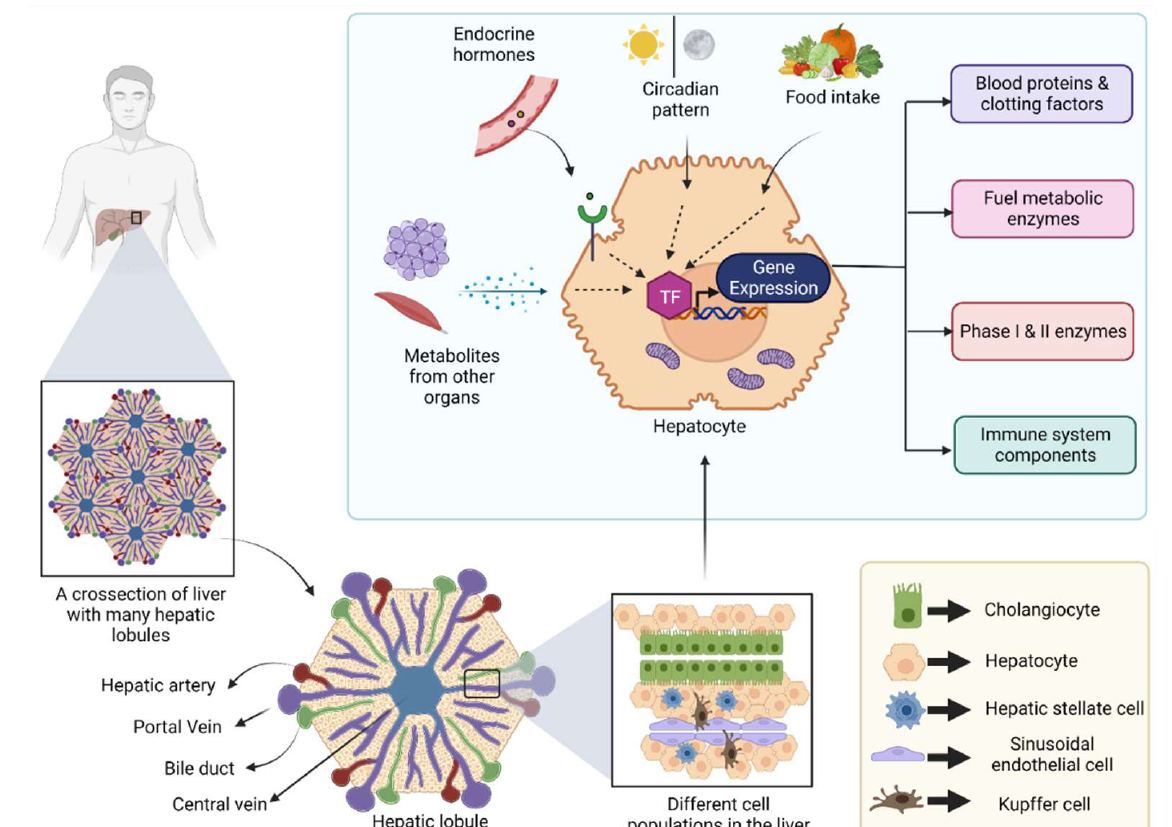
Figure 1. Figure showing different cell populations in the liver and the transcriptional regulation in hepatocytes: Human liver is divided into four lobes, and each lobe contains many hepatic lobules. Each hepatic lobule contains different types of epithelial cells, endothelial cells, and immune cells. Hepatocyte is a specialized parenchymal epithelial cell that can produce several different blood proteins, clotting factors and metabolic enzymes, etc. The gene transcription in hepatocytes is influenced by external stimuli, such as endocrine hormones, and metabolites from other metabolically active organs, food intake, and the day/night cycle. (TF: Transcription factor).